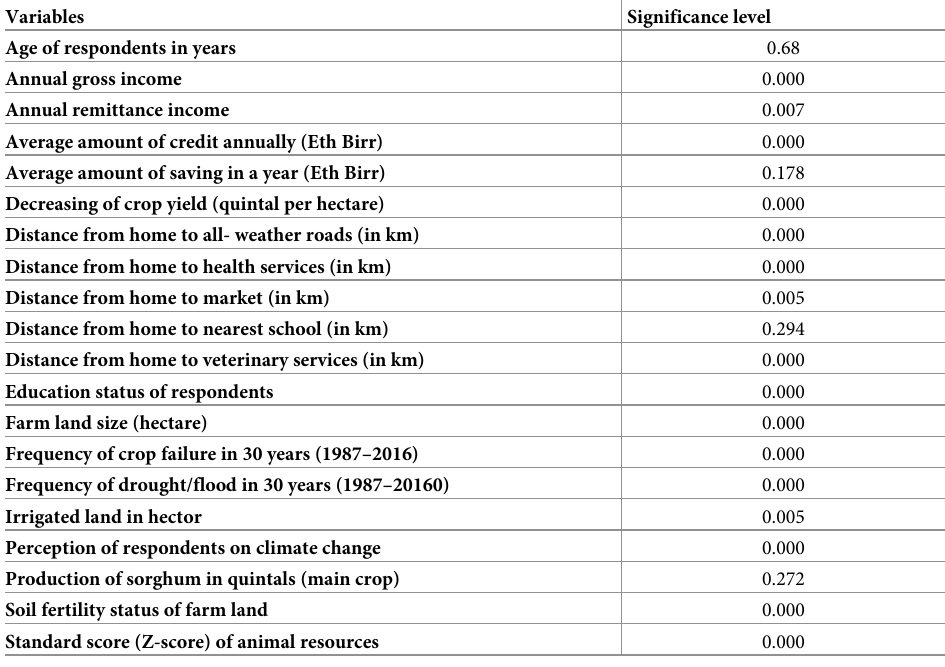
Table 7. Explanatory and ordinal (dependent) variables considered in the Kruskal Wallis Test analysis for the three agro-ecology zones